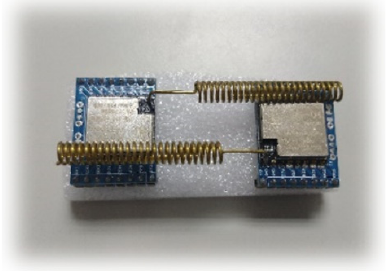
Figure 15. SX LoRa-1278 communication module.